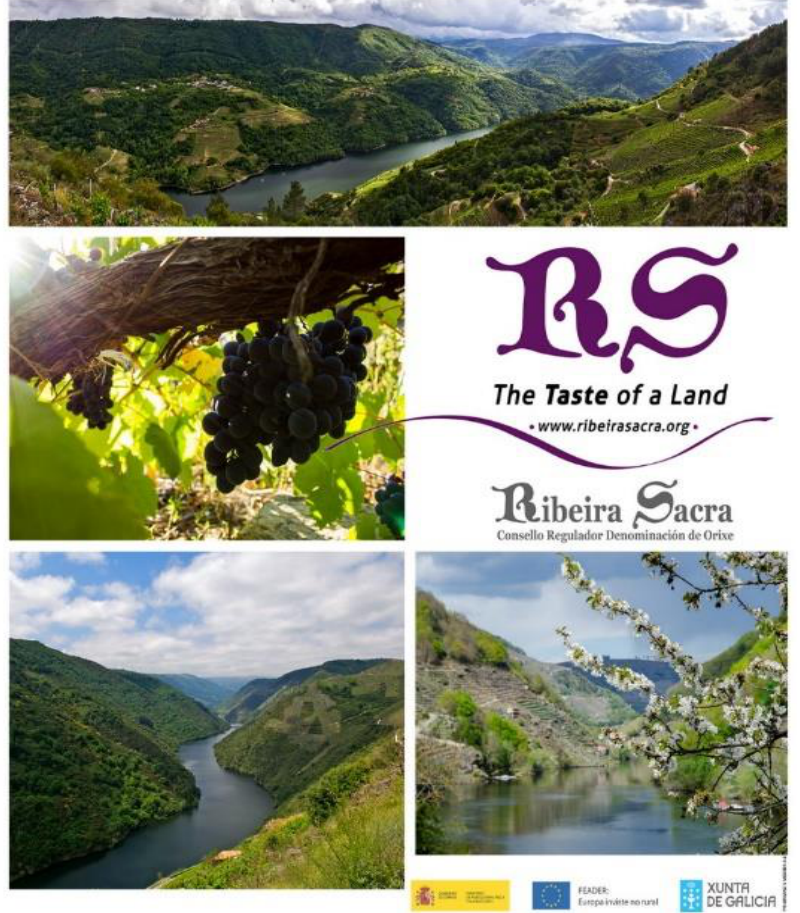
Figure 2. Scenarios of heroic viticulture in Ribeira Sacra (Galicia, Spain). Source: Regulatory Council of the Appellation of Origin Ribeira Sacra [33].